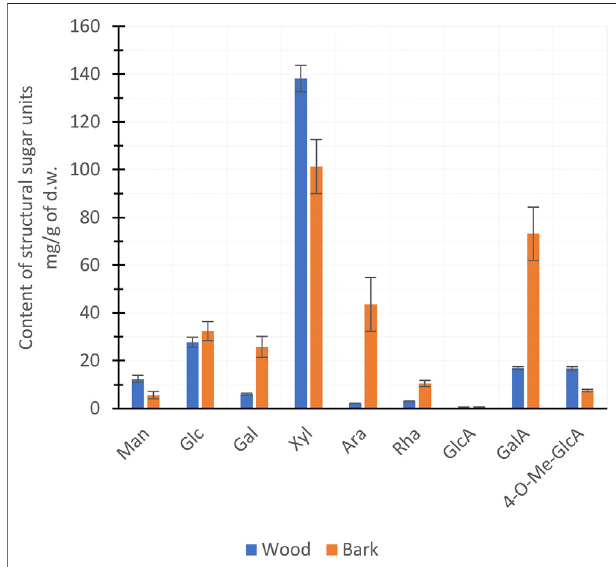
FIGURE2| Mean(±SD)hemicellulosesugarunitsofhybridaspenwood and bark per biomass dry weight